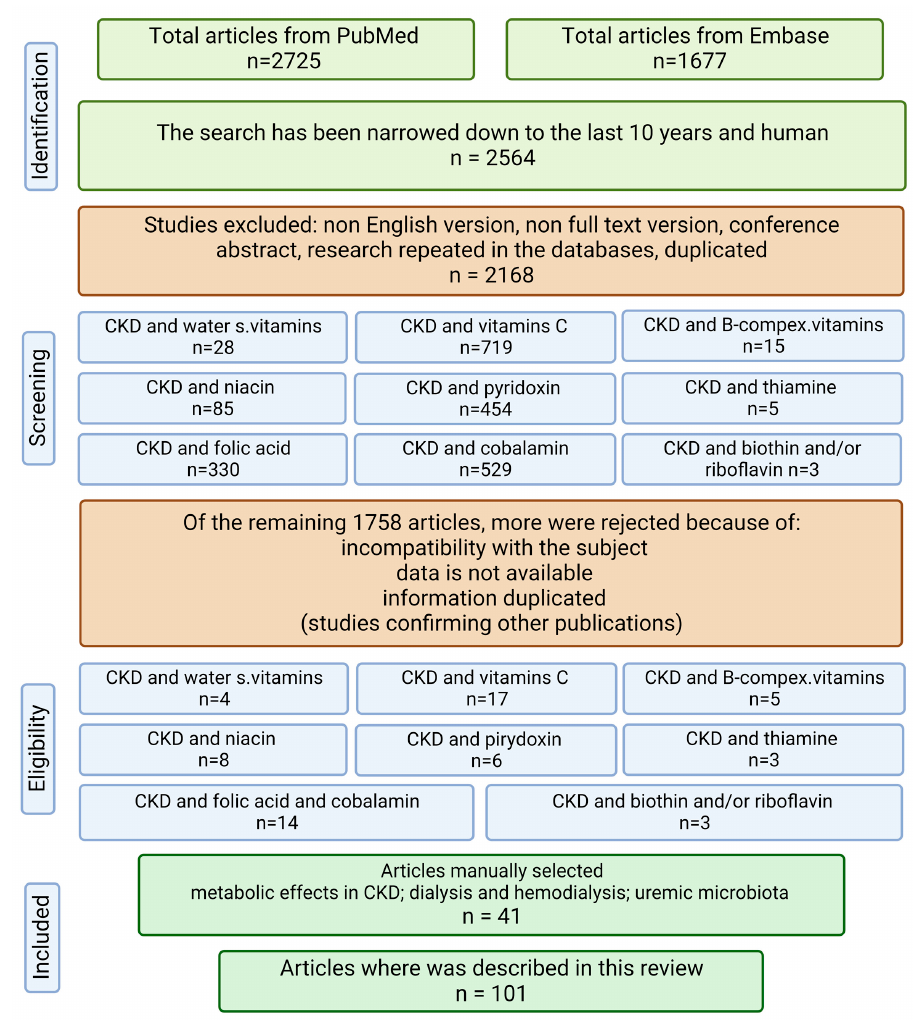
Figure 1. Flow chart of the review (created with BioRender.com https://app.biorender.com/, ac- cessed on 2 February 2023).